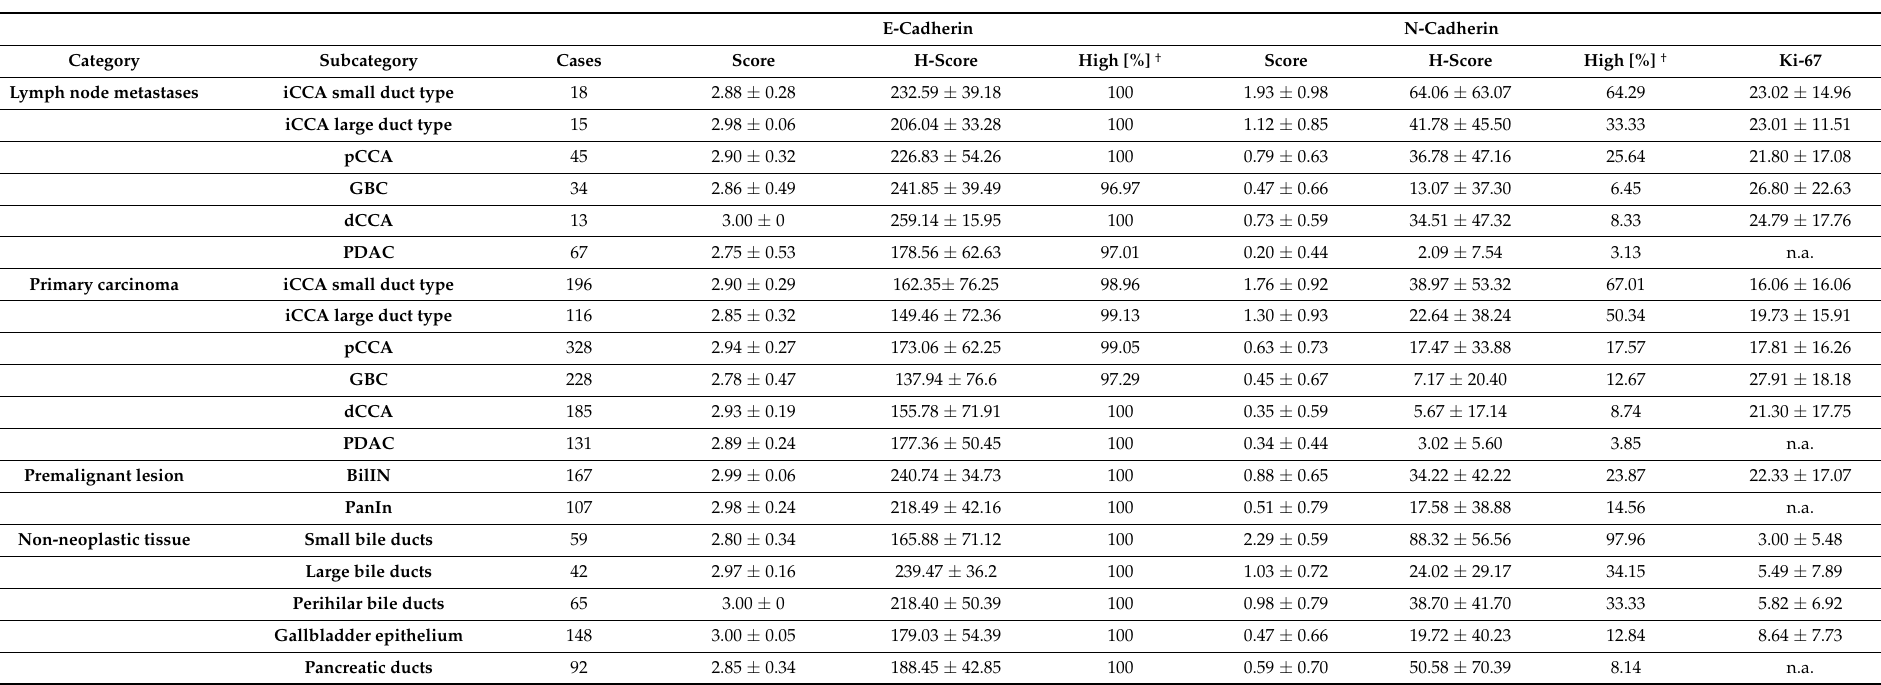
Table 1. Immunohistochemical evaluation of E- andf N-cadherin in iCCA primary carcinoma, premalignant lesions, lymph node metastasis, and normal/ non-neoplastic adult